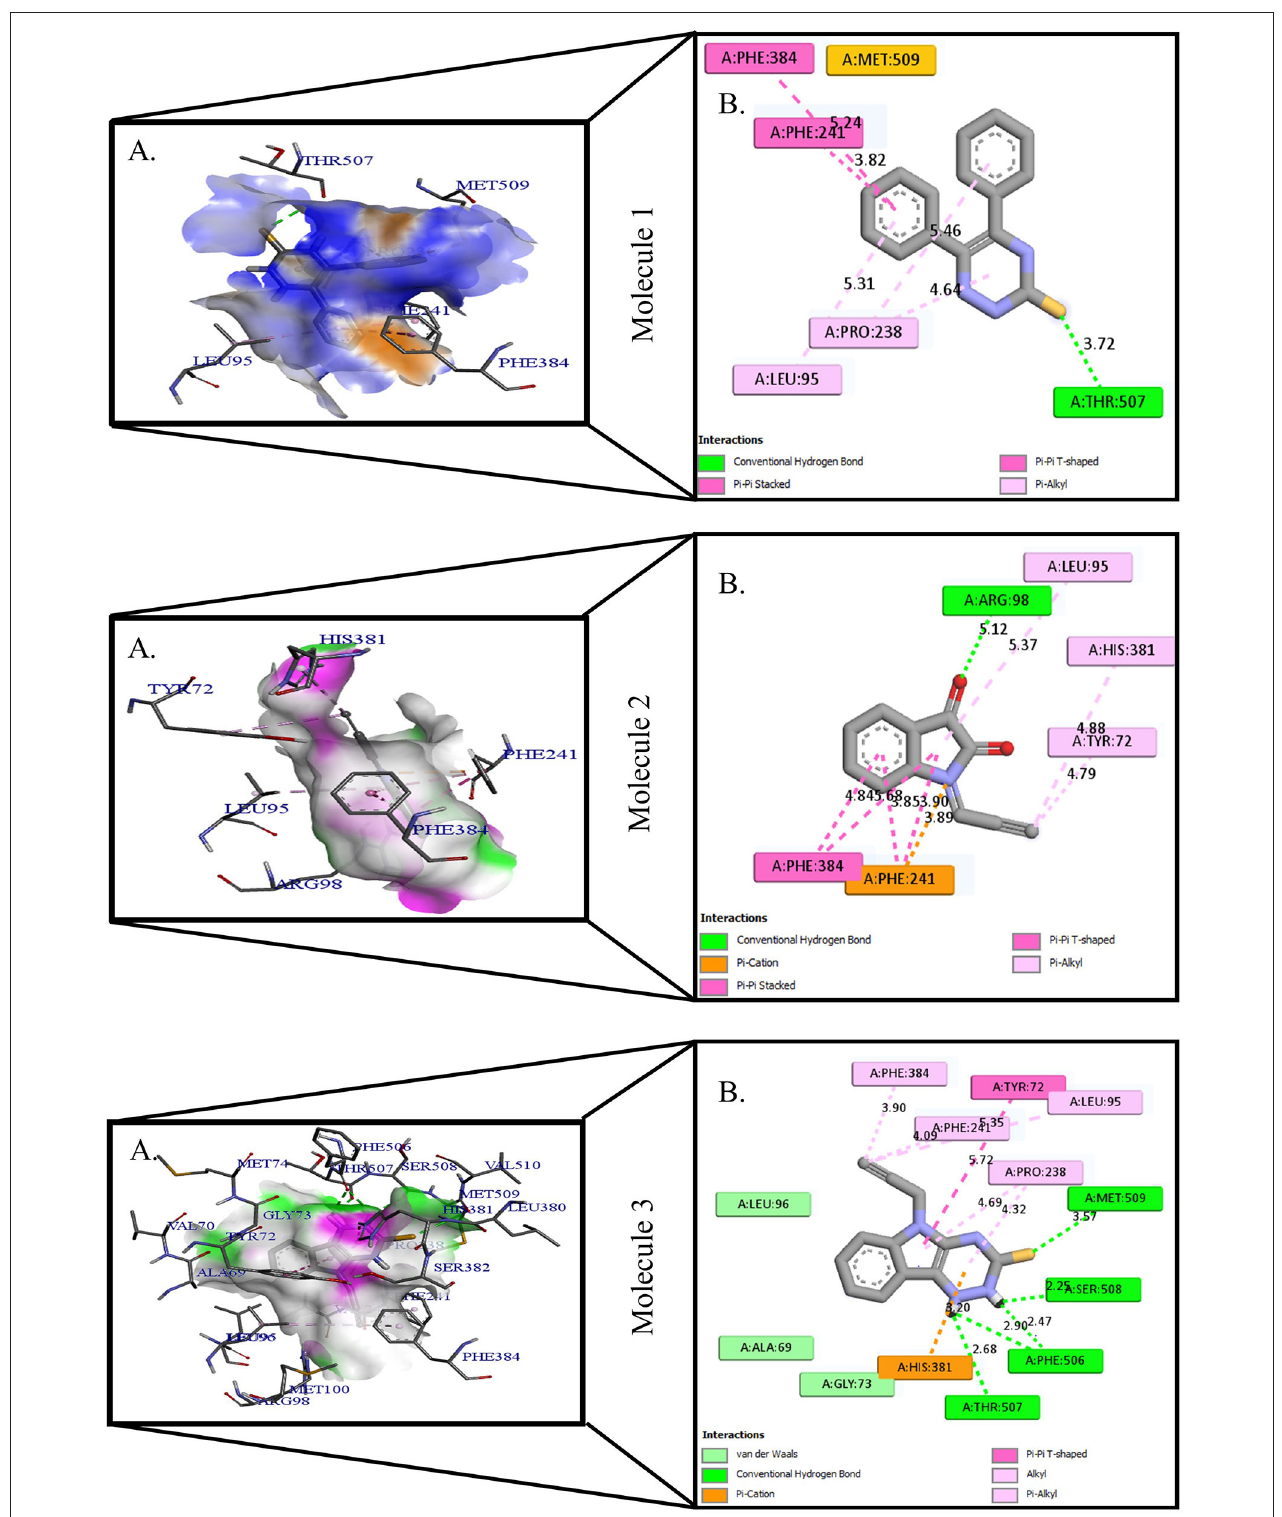
FIGURE 1 | Protein-ligand presentation of CYP51 with molecules 1, 2 and 3. (A) 3D receptor-ligand presentation, and (B) 2D receptor-ligand interactions.